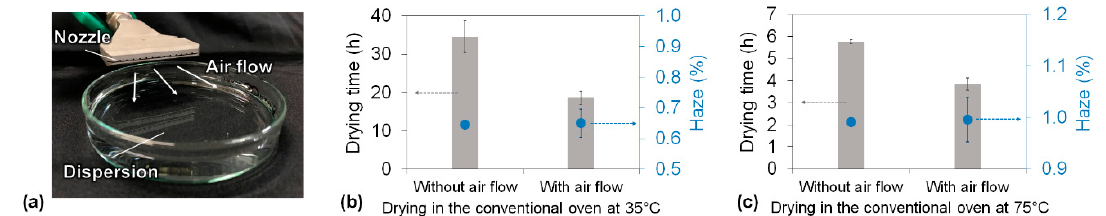
Figure 6. ( a ) The air flow system softly blew toward the dispersion to remove the water vapor at the water / air interface. Drying time of the cellulose nanofiber dispersion and haze of the cellulose nanopaper in the conventional oven with and without the air flow system under ( b ) 35 °C drying and ( c ) 75 °C drying.